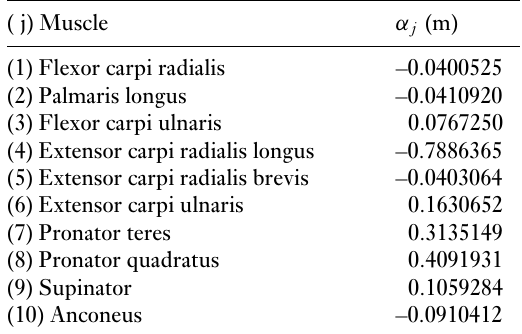
Table 1 Calculated moment arm for muscles controlling wrist